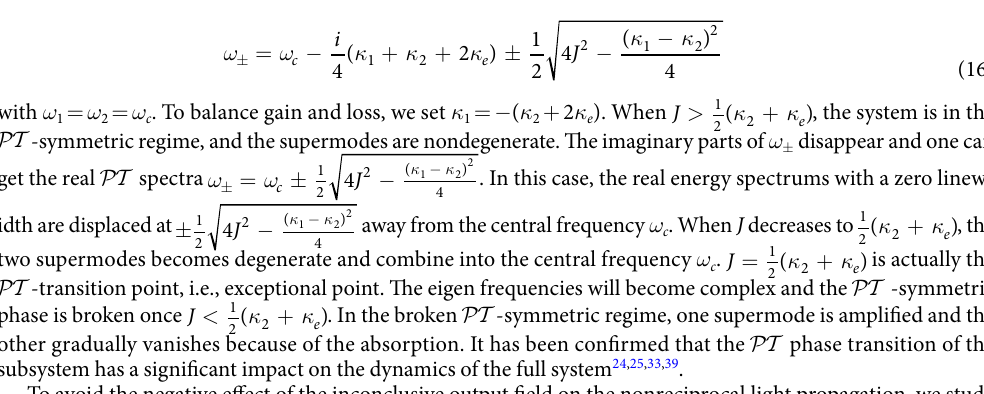
2 with ( a , c ) J = 2 κ 2 and ( b , d ) g = 2 κ 2 . The other system p 2